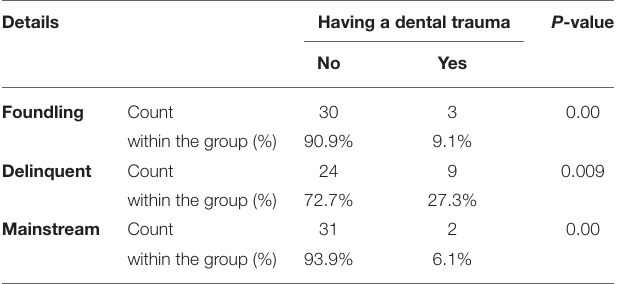
TABLE 6 | The prevalence of dental trauma in foundling, delinquent and mainstream children groups.